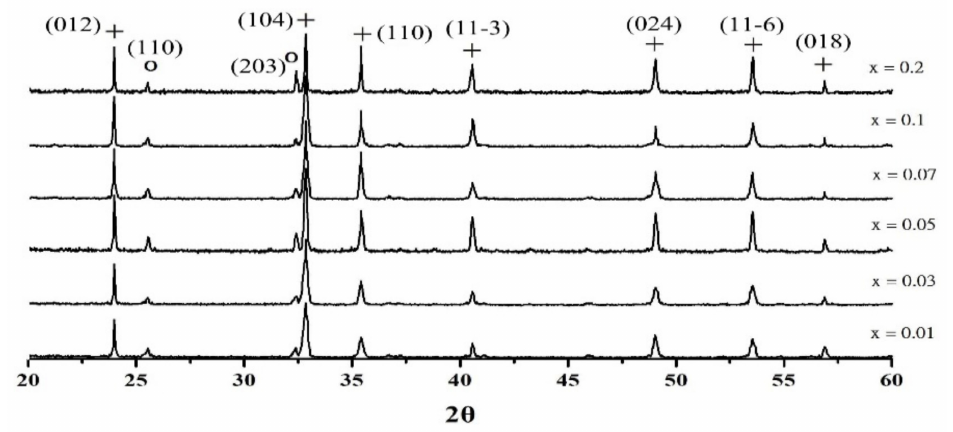
Figure 1. XRD analysis of (Mg 0.6 Zn 0.4 ) 1 − y Ni y TiO 3 (y = 0.01–0.2) sintered at 1200 ◦ C for 4 h. +: (Mg 0.6 Zn 0.4 ) 1 − y Ni y TiO 3 , O: (Mg 0.6 Zn 0.4 ) 1 − y Ni y Ti 2 O 5